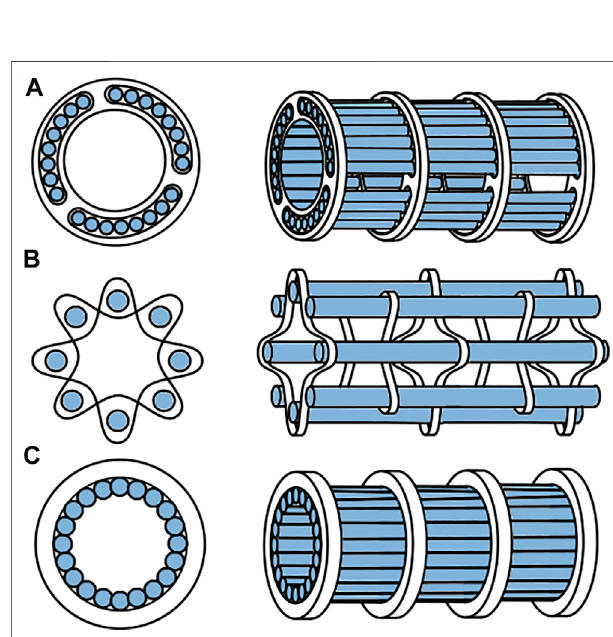
FIGURE 5 | Different options to create an open lumen while still allowing the cables to translate. (A) rings with holes, (B) woven structures, (C) ring